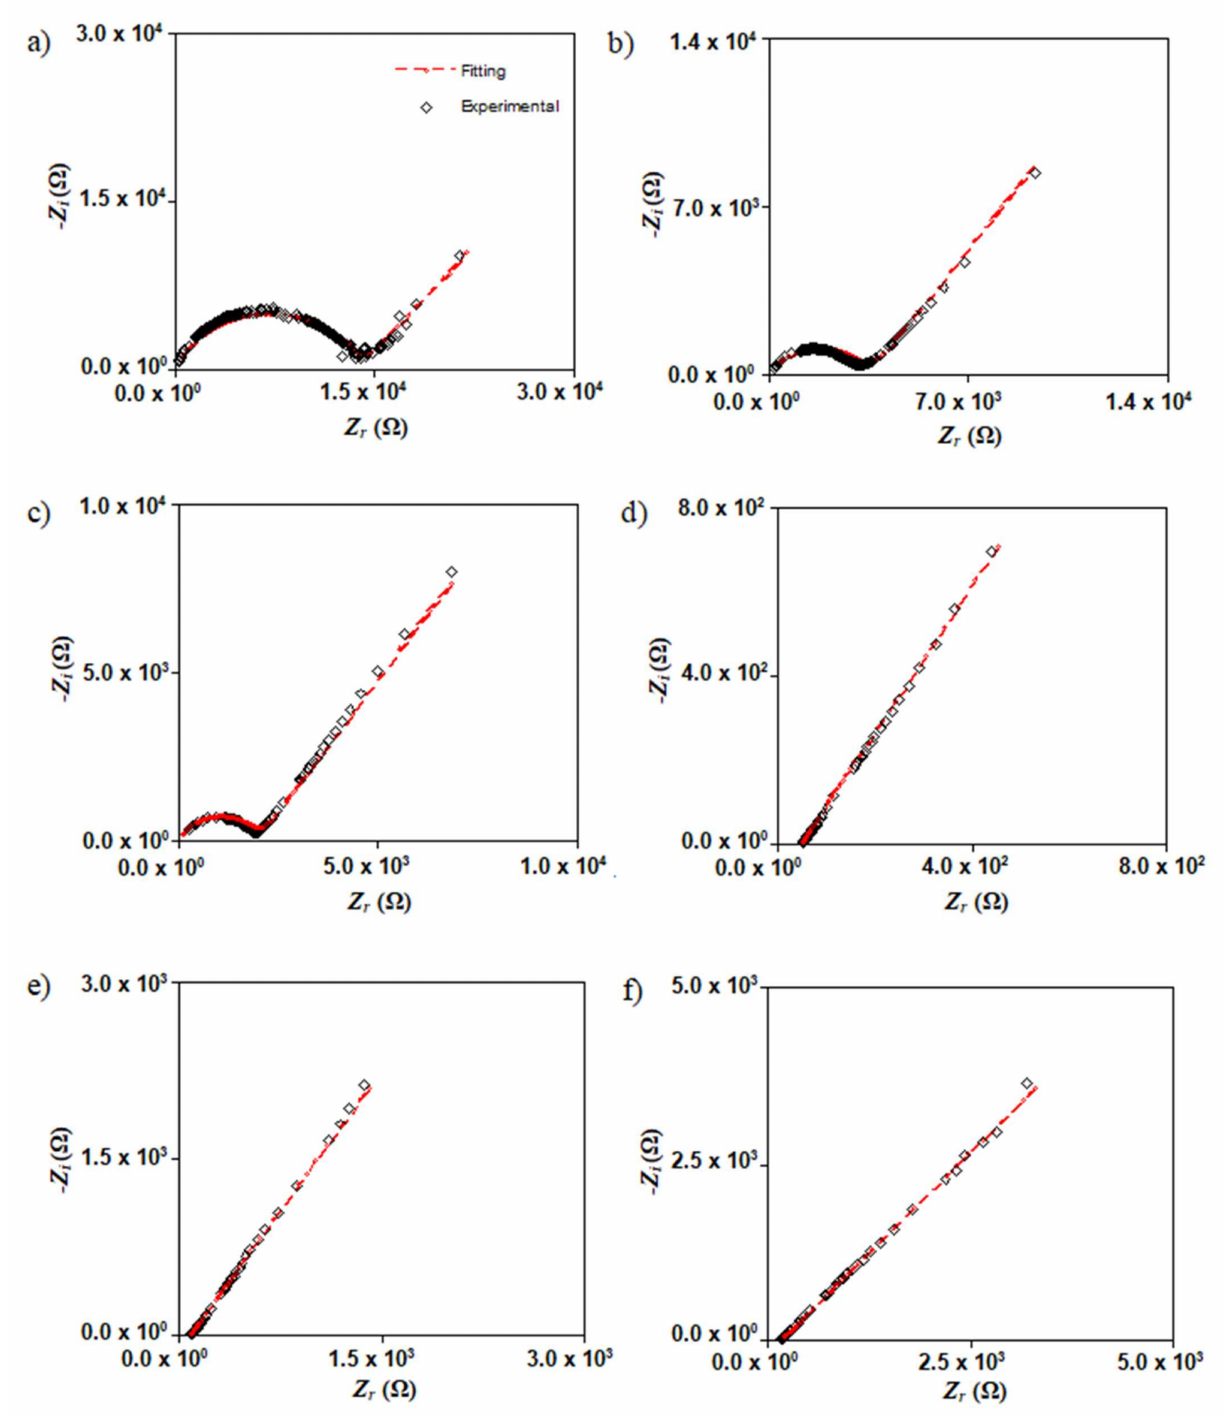
Figure 5. Nyquist plot for ( a ) SL1, ( b ) SL2, ( c ) SL3, ( d ) SL4, ( e ) SL5 and ( f ) SL6 at room